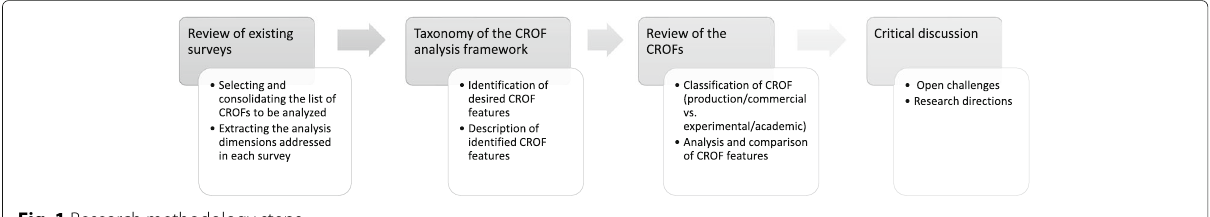
Fig. 1 Research methodology